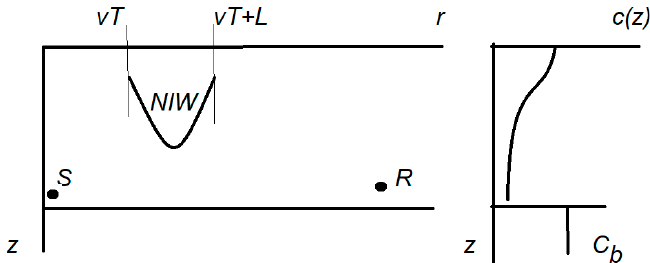
Figure 1. Schematic of acoustic track with a moving nonlinear internal wave (left), sound speed profile (right).